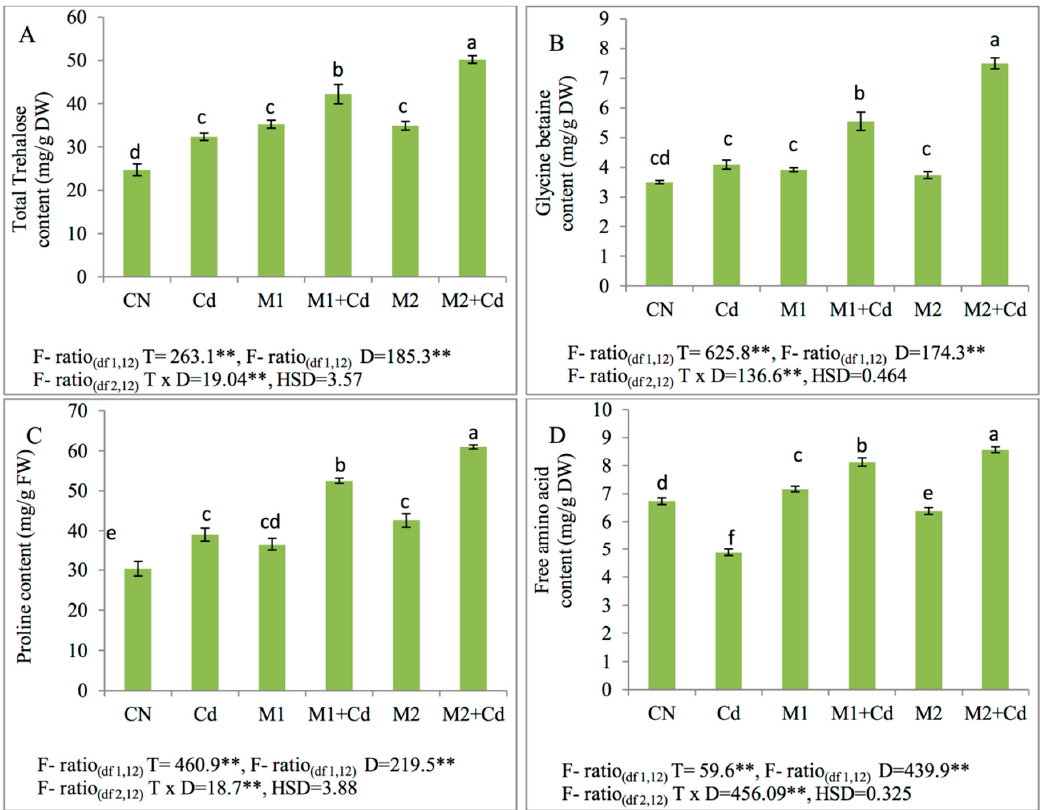
Figure 5. Effect of Cd (0.4 mM), M1 (10 9 cells/mL) and M2 (10 9 cells/mL) and their combinations on different Osmoprotectants ( A ) trehalose content, ( B ) glycine betaine content, ( C ) proline content, and ( D ) free amino acid content in 45-day-old L. esculentum under Cd metal stress. Data is presented as means of 3 replicates ± S.D (standard deviation) and HSD values. F ratio values, * indicates significance at p ≤ 0.05 and ** indicates significance at p ≤ 0.01). Different letters on the table indicate that mean values of treatments are significantly different at p < 0.5 according to Tukey's multiple